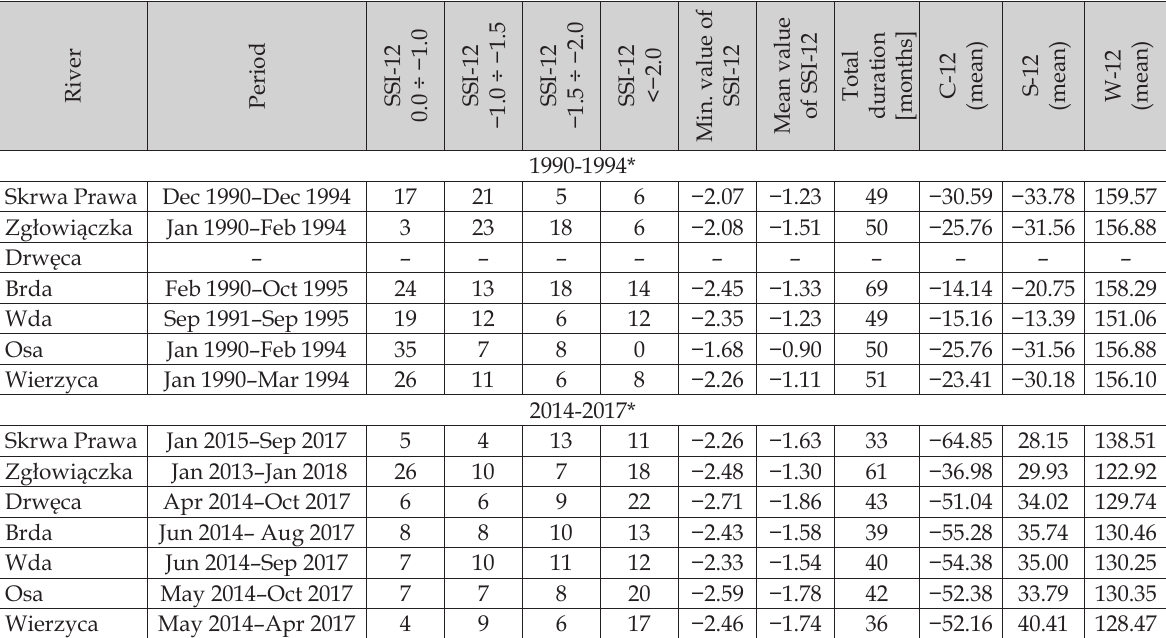
Table 4. Characteristics of a dry period on the analysed rivers and the values of atmospheric circulation indices in 1990-1994* and